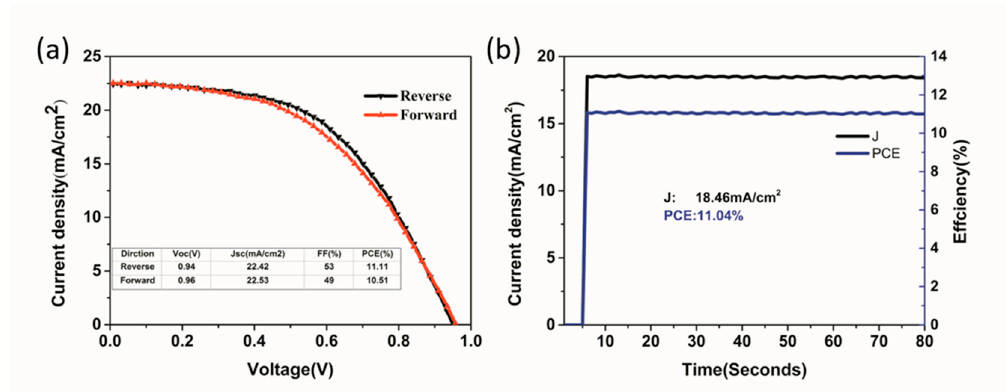
Figure 12. ( a ) Reverse and forward J-V curves of large area (100 mm 2 ) device, and inserted table is the corresponding photovoltaic parameters under forward and reverse scans; ( b ) steady-state current density and efficiency of 100 mm 2 device under continuous illumination at maximum power point (0.6V).